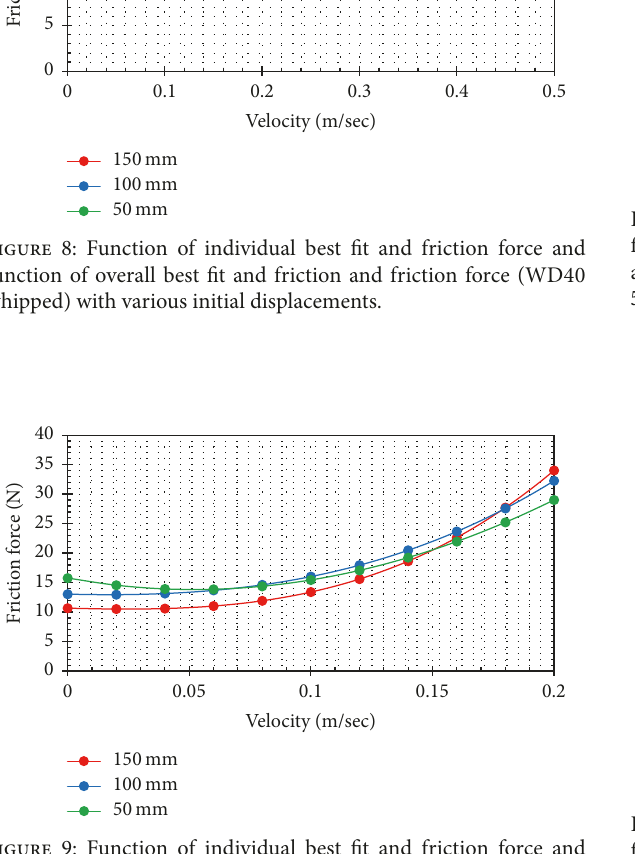
Figure 9: Function of individual best fit and friction force and function of overall best fit and friction and friction force (without lubrication) with various initial displacements.